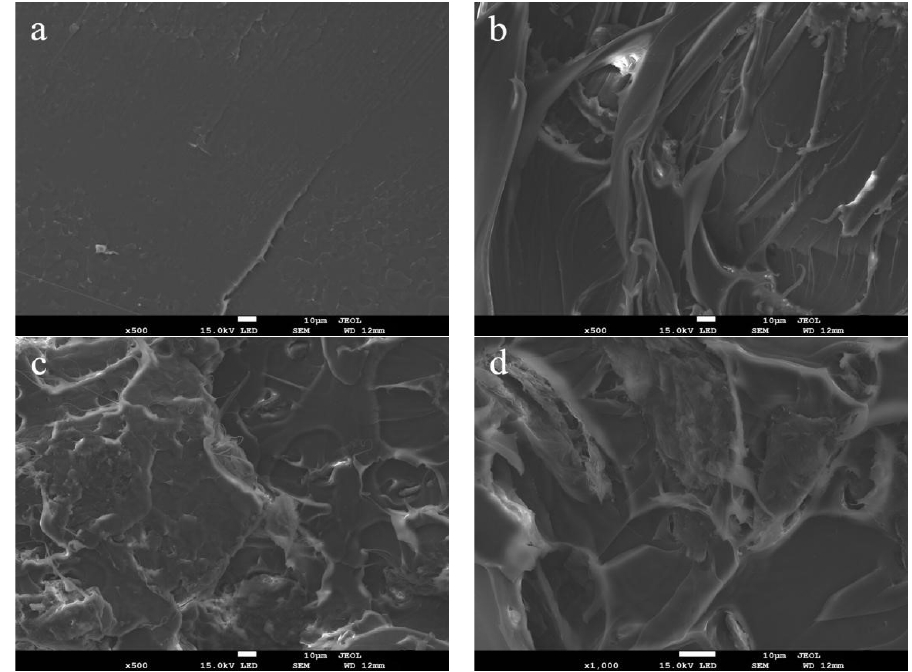
Figure 10. SEM image of cross-section at fracture for neat PLA film and PLA / CNF biocomposite films: ( a ) PLA; ( b ) PLA / CNF-1.0 wt %; ( c ) PLA / CNF-2.5 wt %; and ( d ) PLA / CNF-5.0 wt